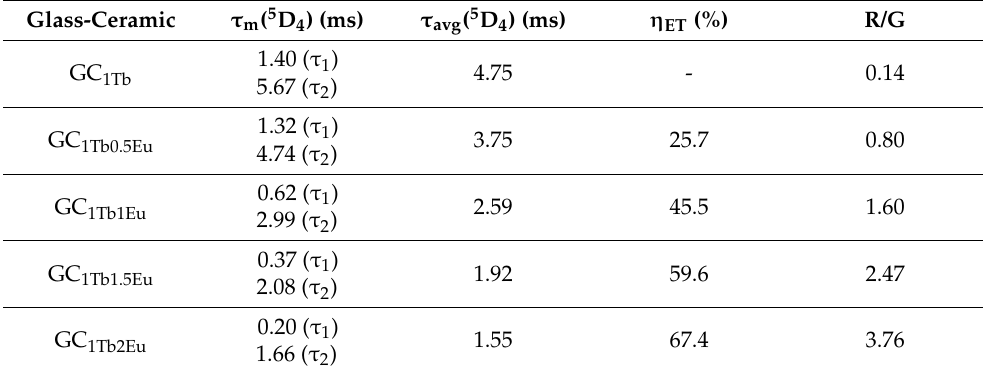
Table 2. Measured lifetimes of the 5 D 4 state (Tb 3+ ), average decay times, energy transfer efficiencies, and R/G ratio values for prepared